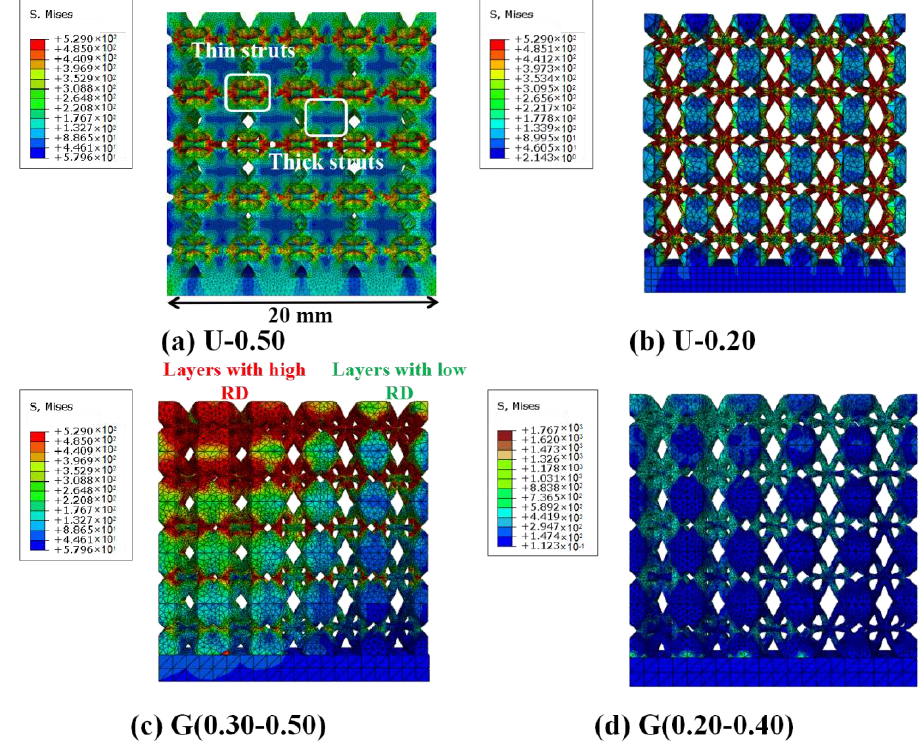
Figure 10. FEM results of maximum principal stress distribution on the surface of lattice structures at 0.02 strain under compressive loading: ( a ) U(0.50), ( b ) U(0.20), ( c ) G(0.30 – 0.50) and ( d ) G(0.20 – 0.40).